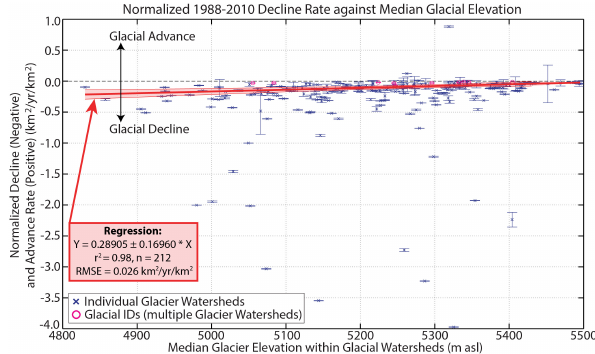
Fig. 15. Normalized (against median area) decline rates against me- dian glacial elevation within individual glacial watersheds. Water- sheds were delineated using the SRTM DEM and standard GIS pro- cedures. A total of 212 glacial watersheds were used to calculate decline rates for each watershed basin based on the satellite-image time series. Watershed areas range from <1km 2 to a few dozen km 2 with a mean area of 3km 2 . Error bars of the regression indi- cate 95%